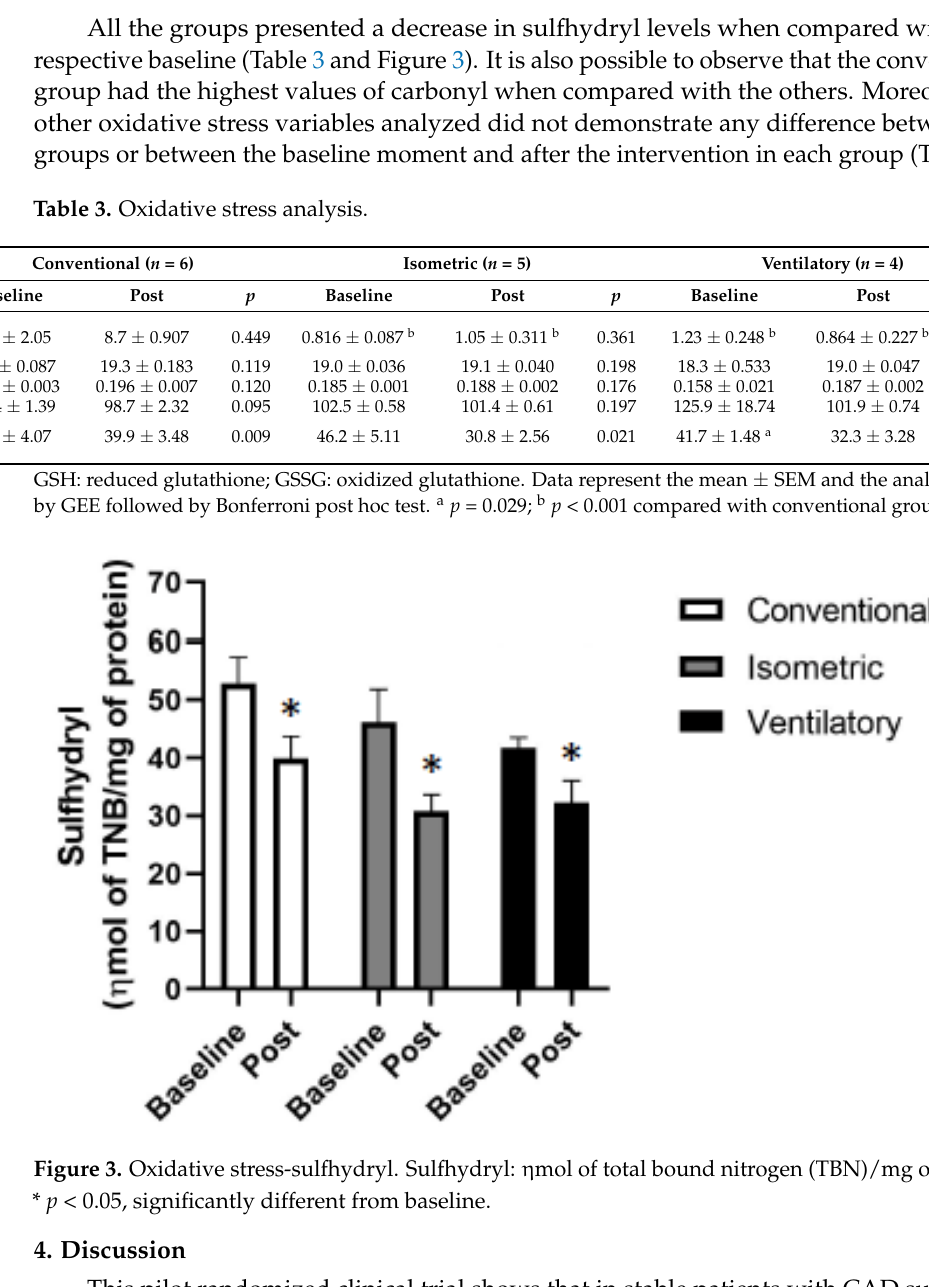
Table 3. Oxidative stress analysis.